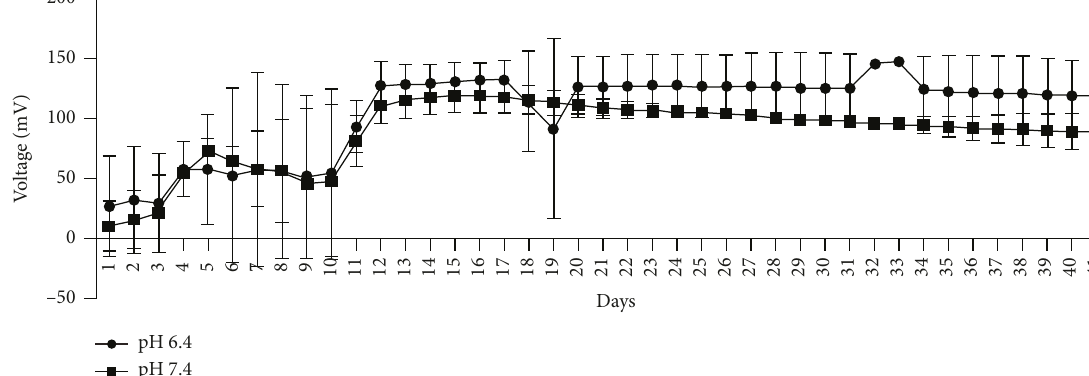
Figure 3: Daily average voltage (mV) recordings from a dual-chambered MFC (5cm 2 electrodes) unit with H. salinarum as the anodic organism at either pH 6.4 or 7.4 at a ratio of 1:24, maintained at 37 ° C, with constant shaking at 50rpm. Each data point is the daily average voltage (mV) recorded every 30 minutes over 42 days from two separate trials at each pH. The voltage was higher ( p � 0 . 01) when the anolyte and catholyte were at pH 6.4 compared to 7.4, as per unpaired T -test with Welch correction. Table 1: Summary of results on the effect of electrode surface area and oscillation on voltage, current, and power density generation. Total